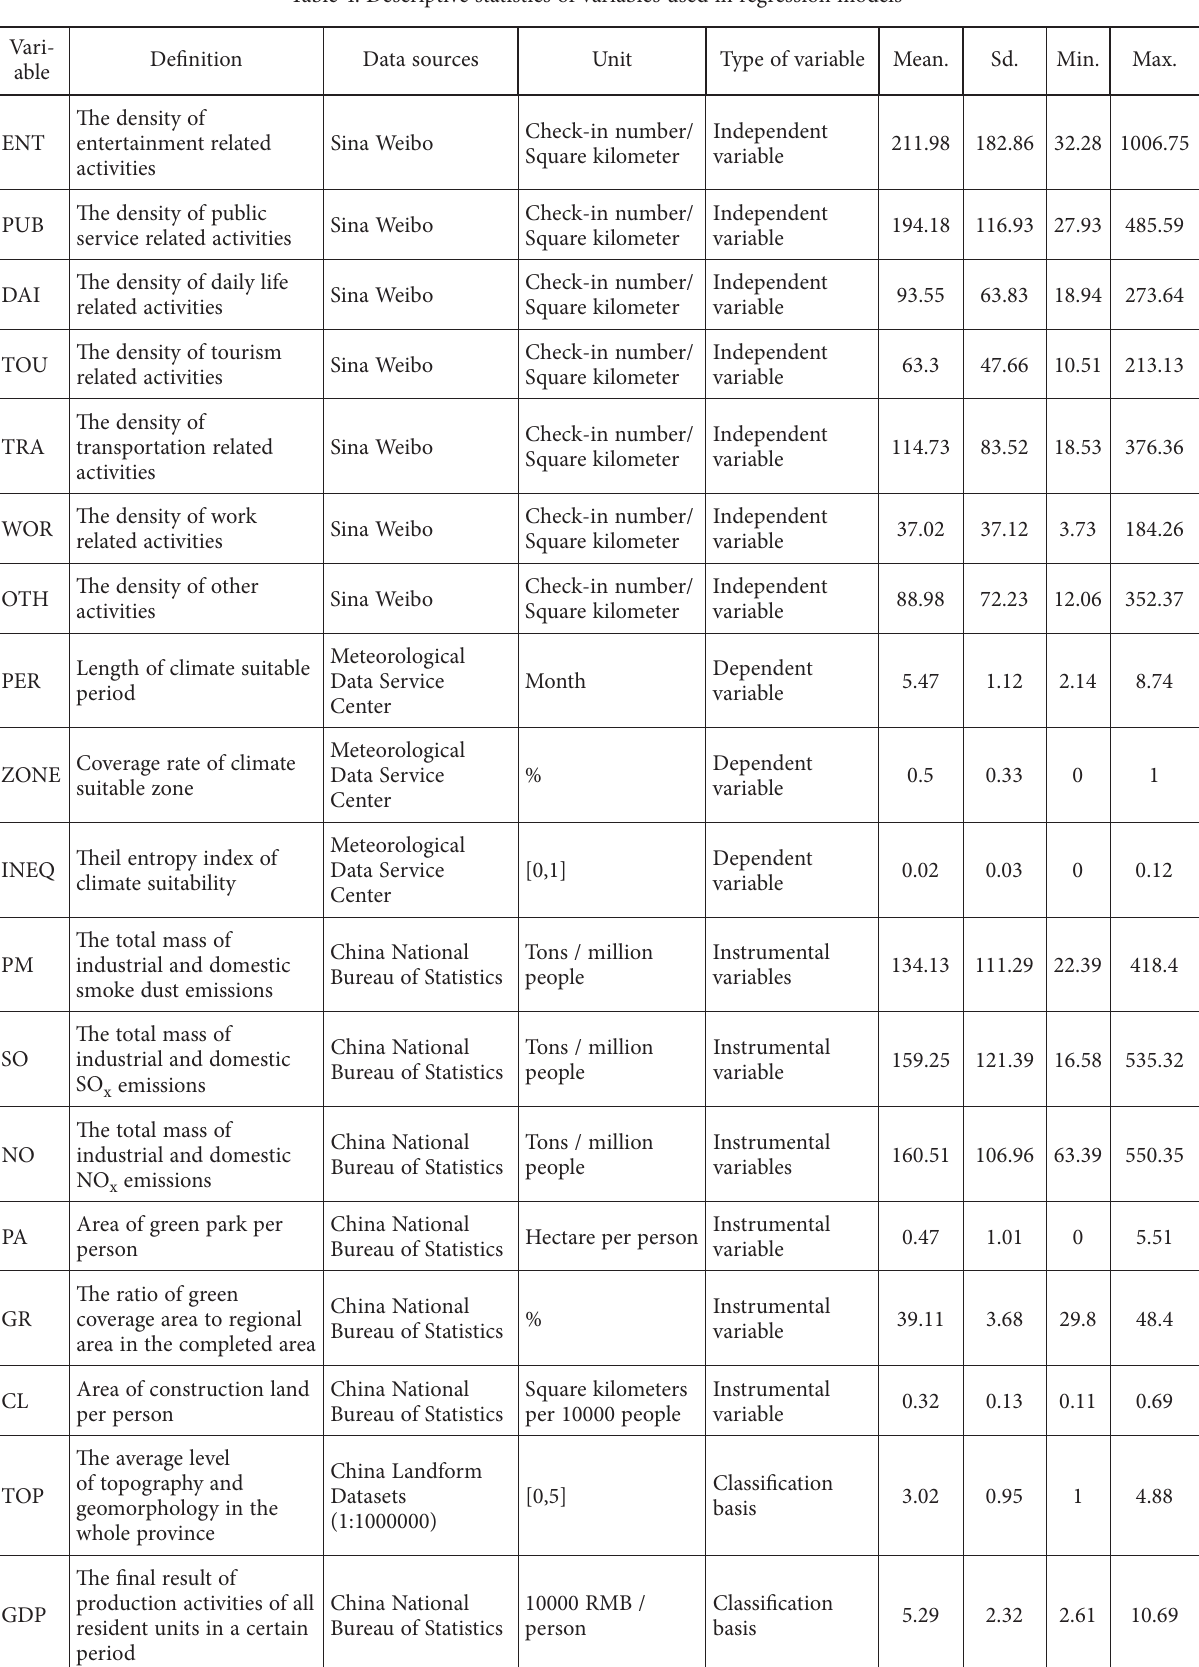
Table 4. Descriptive statistics of variables used in regression